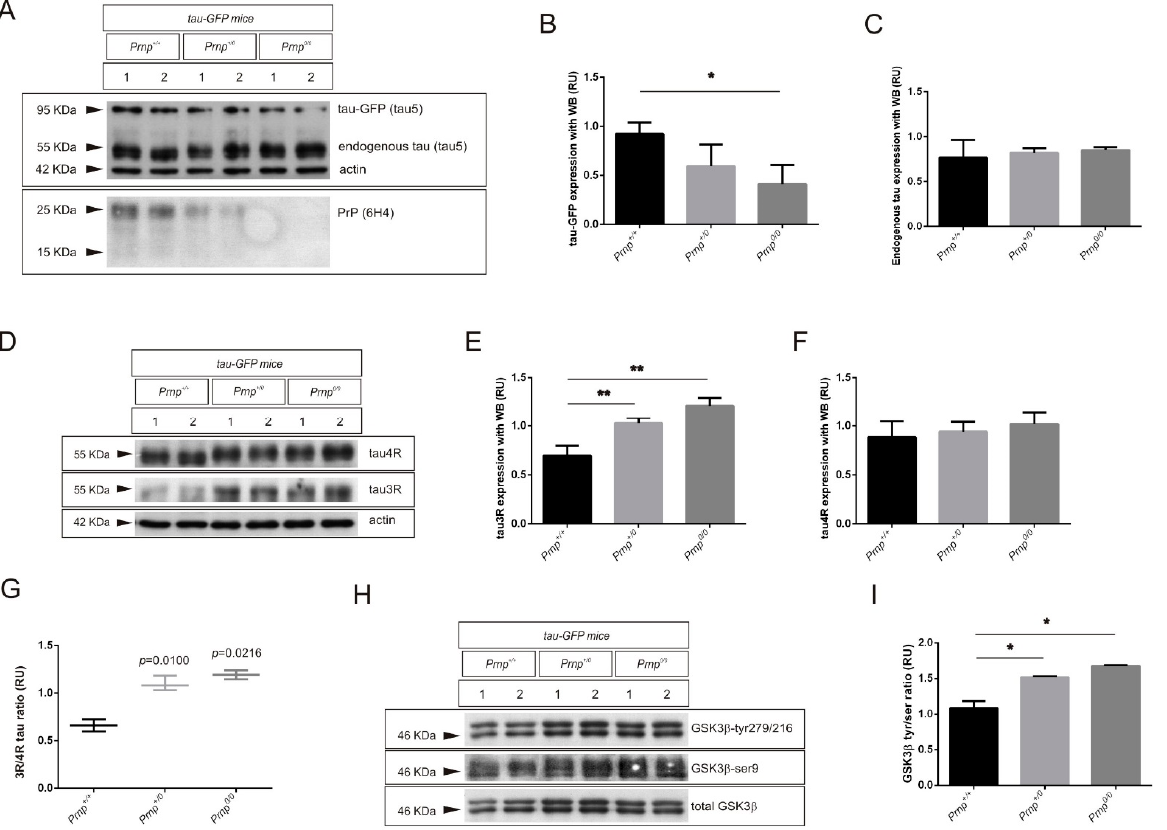
Figure 3. Effects on tau, alternative exon 10 forms, and GSK3 β in tau transgenic mice overexpressing tau-GFP after ablation of PrP C expression. ( A – C ) Total tau expression analyzed in brain extract from tau-GFP, tau-GFP- Prnp +/0 , and tau-GFP- Prnp 0/0 mice at the age of 3 months. ( A ) Representative WB analysis using total anti-tau antibody (monoclonal Tau5) in parallel with anti-PrP C antibody (monoclonal 6H4) in each case. Actin detection was used as control loading protein. ( B ) Histograms showing the densitometry study of tau-GFP expression in each genotype. ( C ) Histograms showing the densi- tometry study of endogenous tau expression in each genotype. ( D – G ) Endogenous 3R and 4R tau isoforms expression analyzed in brain extract from tau-GFP, tau-GFP- Prnp +/0 , and tau-GFP- Prnp 0/0 mice at the age of 3 months. ( D ) Representa- tive WB analysis using anti-3R tau antibody (monoclonal RD3) in parallel with anti-4R tau antibody (monoclonal RD4) in each genotype. Actin detection was used as control loading protein. ( E , F ) Histograms showing the densitometry study of 3R tau ( E ) and 4R tau ( F ) expression in each genotype. ( G ) Graphical representation of the 3R/4R tau ratio analyzed with data represented in ( E , F ). ( H , I ) GSK3 β activation analyzed with WB in brain extract from tau-GFP, tau-GFP- Prnp +/0 , and tau-GFP- Prnp 0/0 mice at the age of 3 months. ( H ) Representative WB analysis using anti-phospho-tyr 279/216 GSK3 antibody (monoclonal 5G-2F) in parallel with anti-phospho-ser 9 GSK3 antibody (monoclonal 2D3) in each case. Membranes were re-probed with antibody against total GSK3 (monoclonal 4G-1E) for protein standardization. ( I ) Histograms showing the quantified ratio between phospho-tyr 279/216 and phospho-ser 9 after densitometry analysis of both phosphorylated GSK3 β epitopes in each genotype, which represents the kinase activity. n = 3 mice were examined in each group and data repre- sents the mean ± S.E.M. Differences between groups were considered statistically significant at ** p < 0.01 and * p < 0.05 ( t - test).